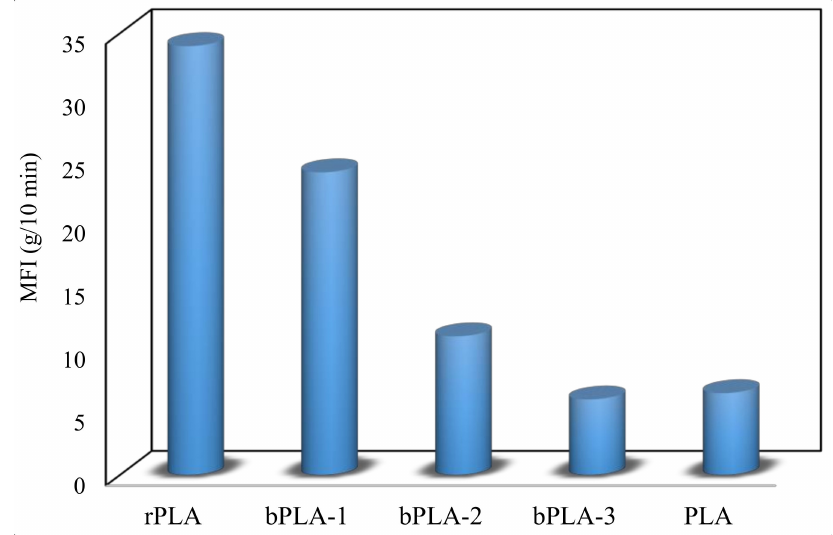
Figure 7. Melt flow rate for rPLA and chain extended rPLA